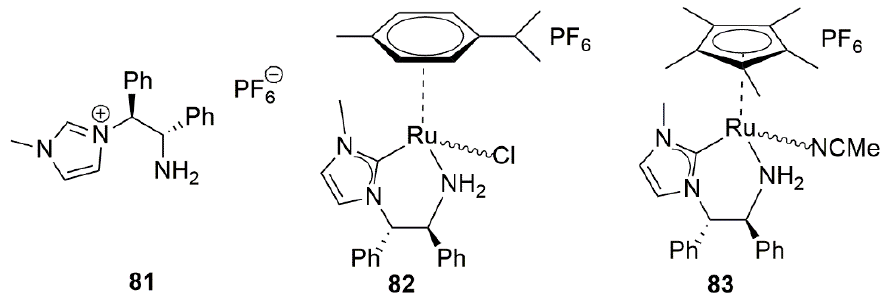
Figure 6. Chiral NHC ‐ NH 2 ligand 81 and its ruthenium complexes 82 and 83 [31,140].